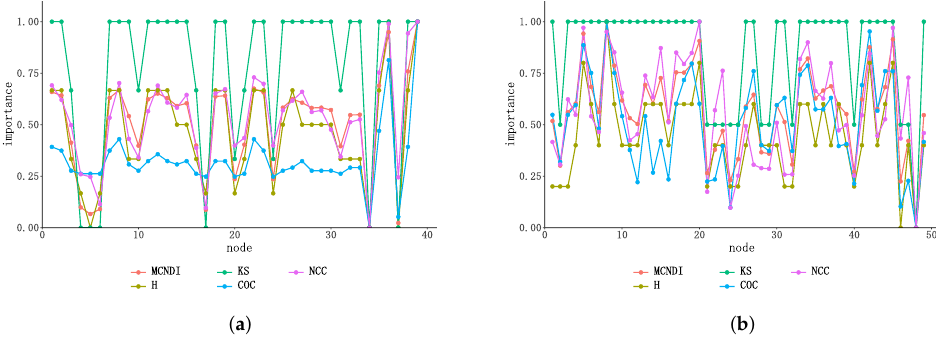
Figure 3. Simulation comparison chart of the importance of different indicators on network nodes. ( a ) Ranking of the importance of network nodes in the simulated Chesapeake Bay network. ( b ) Rank- ing of the importance of network nodes in the simulated contiguous USA network.